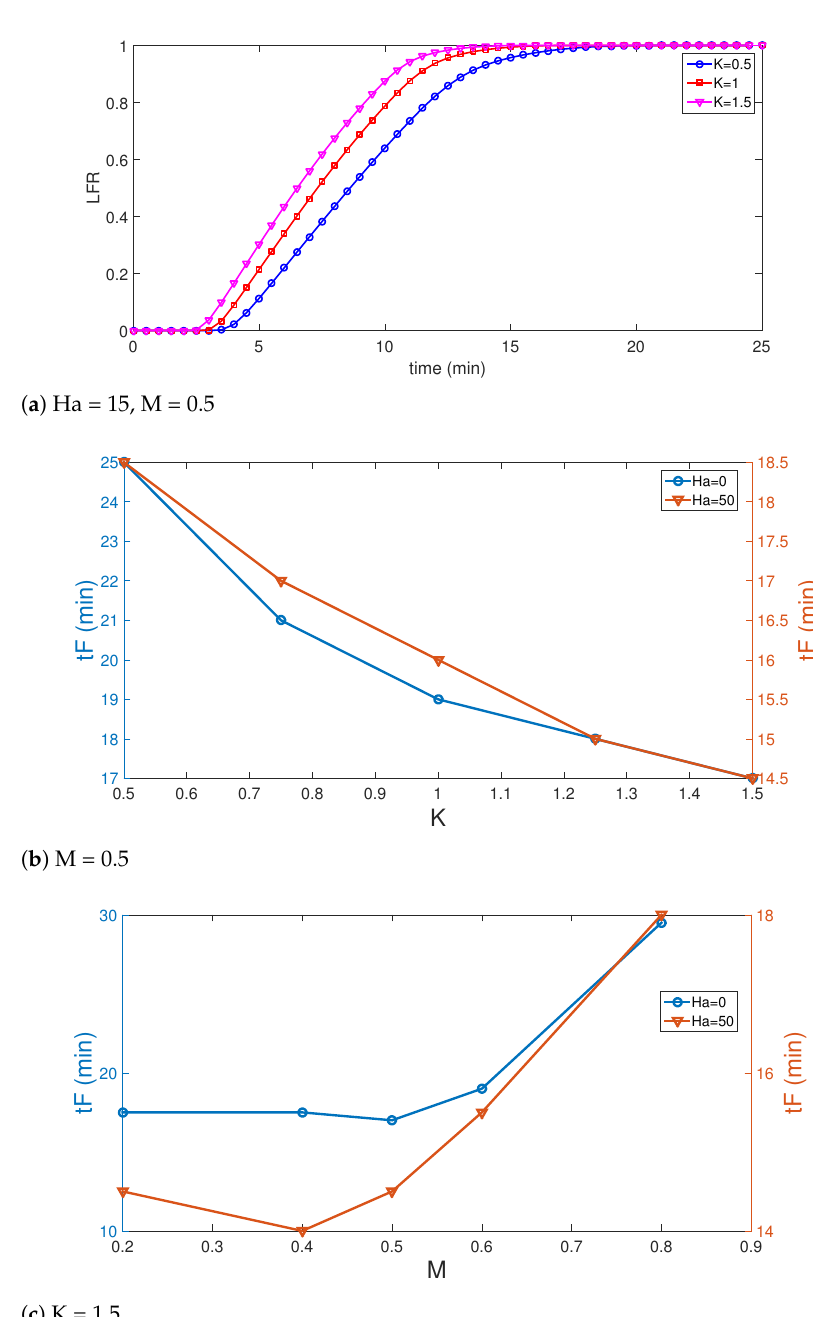
Figure 7. Impacts of the sequential velocity parameter (K) on the time evolution of the liquid fraction (LFR) ( a ) and complete phase transition time ( b ); effects of the conic aspect ratio (M) on the time- dependent variation of phase completion time ( c ). In case ( b , c ), left and right y-axes show results for Ha = 0 and Ha = 50 (constant MF, φ =